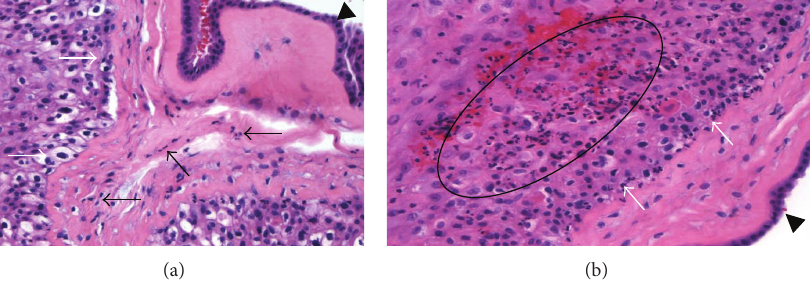
Figure 1: (a) Medium power magnification with Hematoxylin and Eosin staining revealing a moderately diffuse infiltrate of polymorphonu- clear white blood cells (black arrows) between the amnion (arrowhead) and the chorion (white arrows). (b) Medium power magnification with Hematoxylin and Eosin staining revealing chorionitis with a dense infiltrate of polymorphonuclear white blood cells (encircled) within the chorion (white arrow). The amnion is also visible